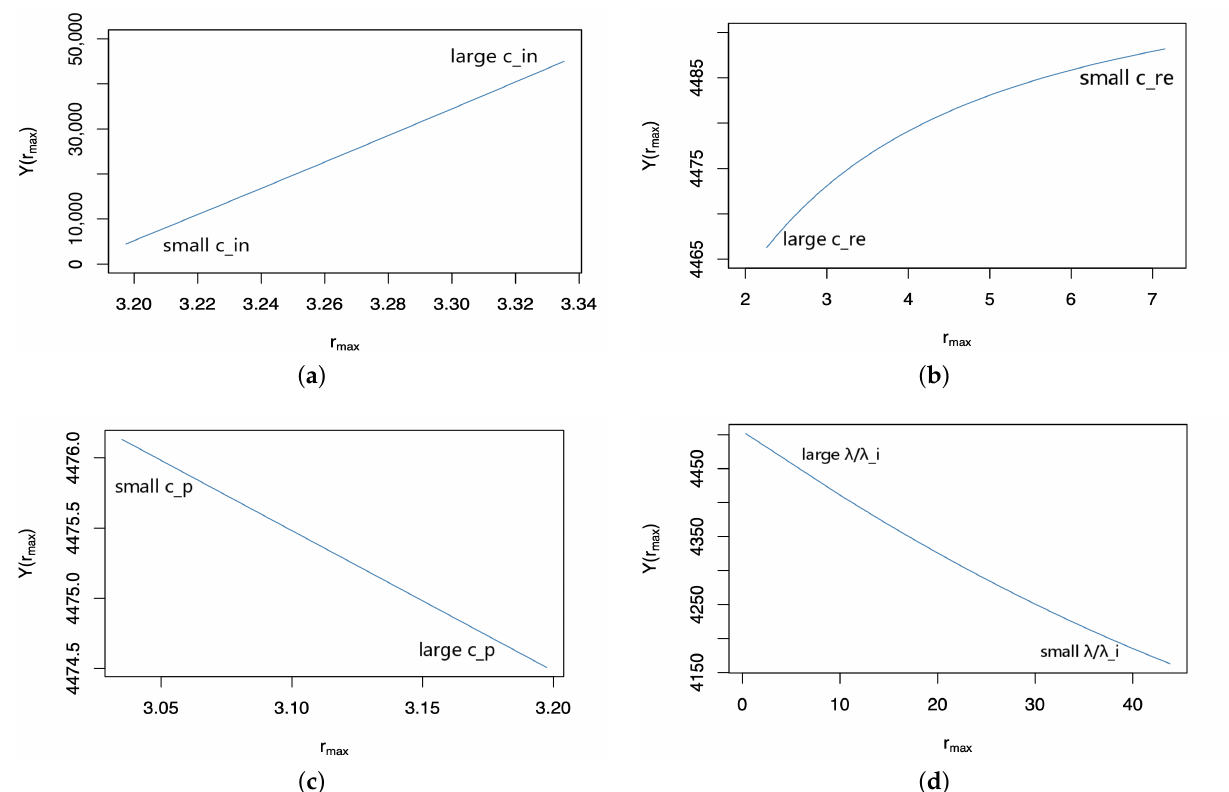
Figure 7. Effect of revenue- and cost-related parameters and arrival rates. ( a ) The maximum profit after implementing the relocation strategy with respect to the optimal relocation frequency under the influence of c in ; ( b ) The maximum profit after implementing the relocation strategy with respect to the optimal relocation frequency under the influence of c re ; ( c ) The maximum profit after implementing the relocation strategy with respect to the optimal relocation frequency under the influence of c p . ( d ) The maximum profit after implementing the relocation strategy with respect to the optimal relocation frequency under the influence of λ λ i